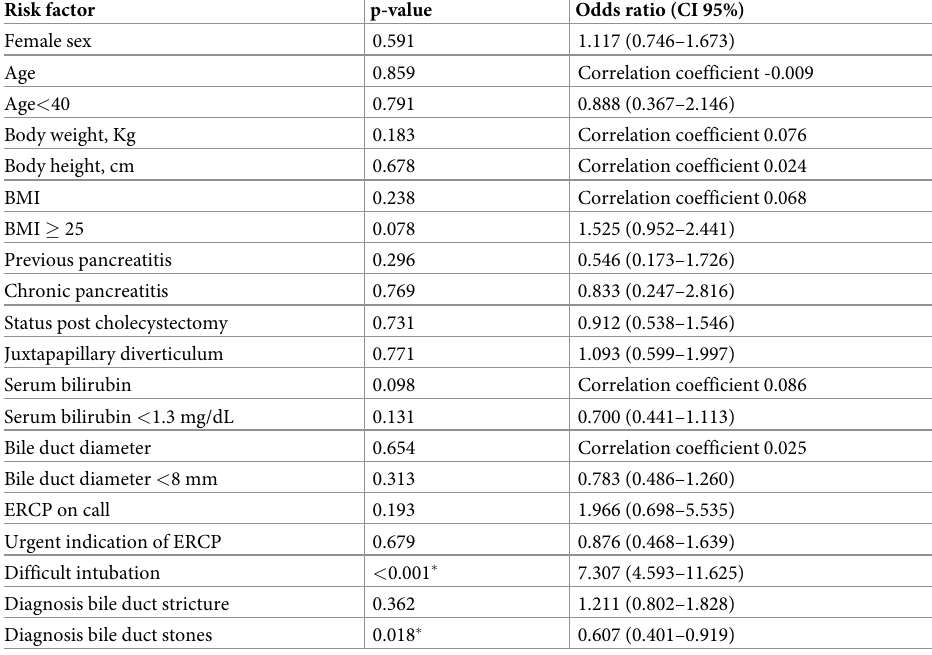
Table 3. Risk factors for inadvertent cannulation of pancreatic